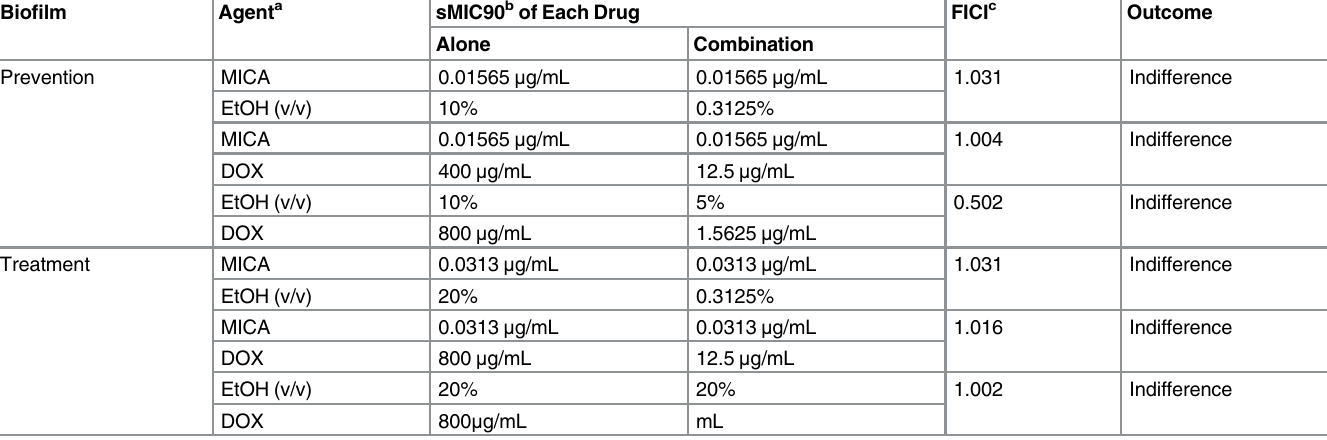
Table 1. Antifungal activity of two-drug combinations against forming and mature C . albicans biofilms, sMIC90. Bio fi lm